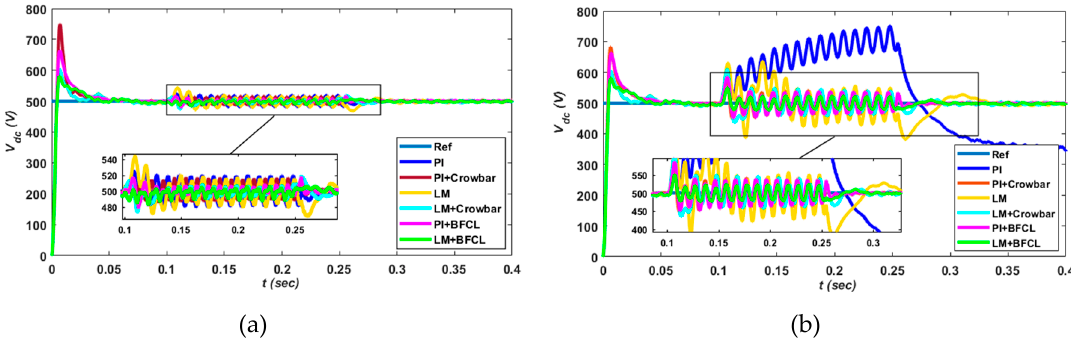
Figure 8. DC-link voltage response for P-G 8 ( a ) and P-P 8 ( b ) at PCC.